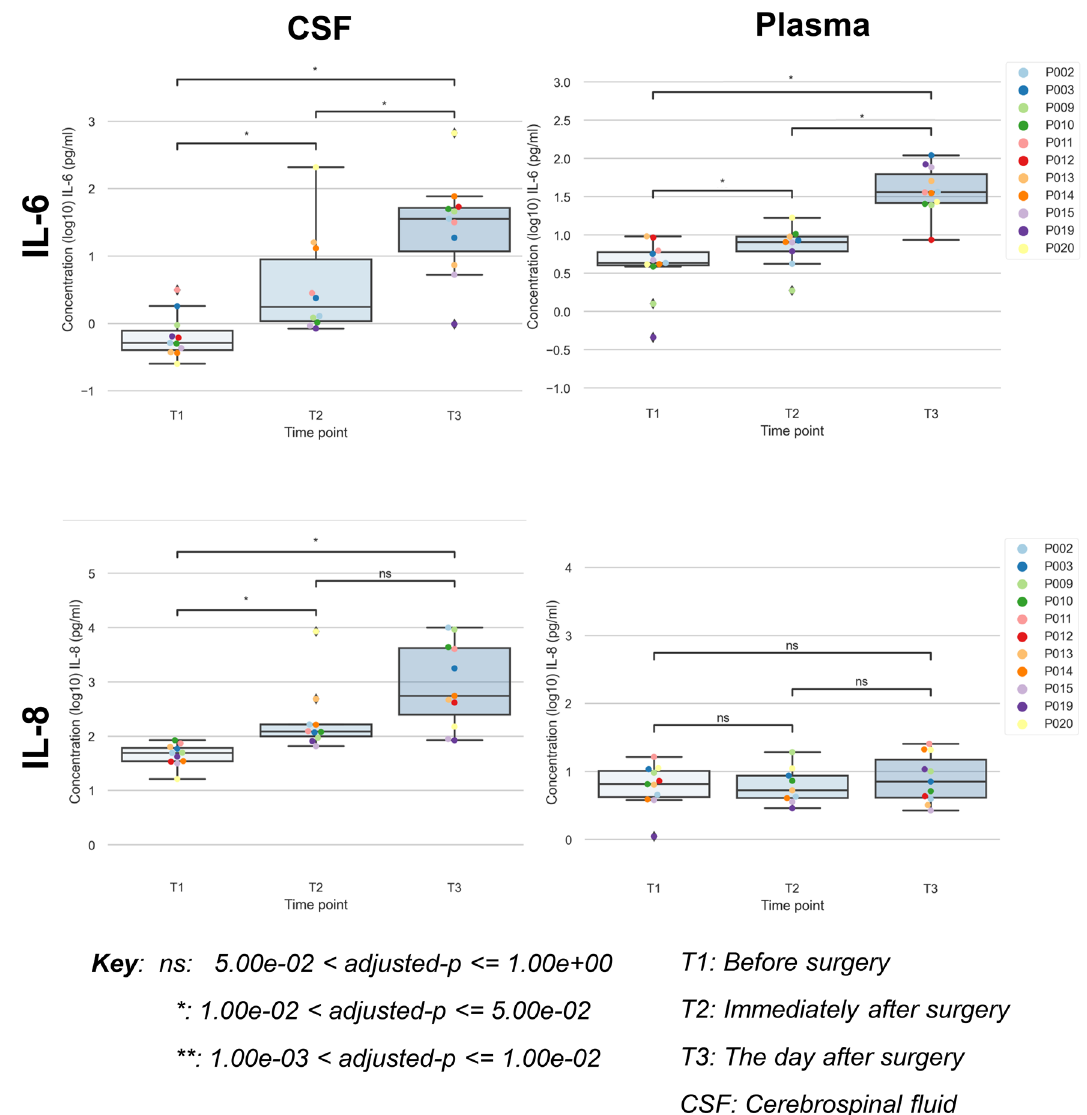
Figure 1. Peri-operative changes in IL-6 and IL-8 in plasma and CSF. Changes in IL-6 and IL-8 in plasma and cerebrospinal fluid (CSF) before surgery (T1), immediately after surgery (T2) and the day after surgery